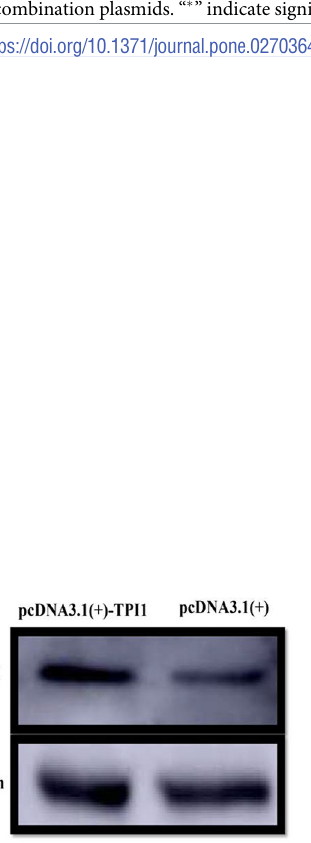
Fig 3. Expression patterns of TPI1 protein in SCs after silencing or overexpression.